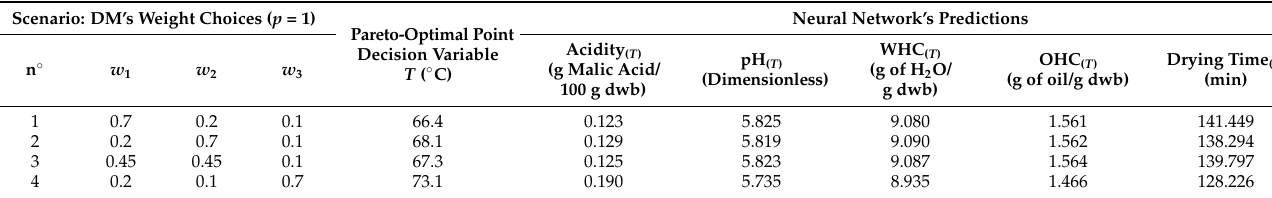
Table 6. Possible scenario outcome